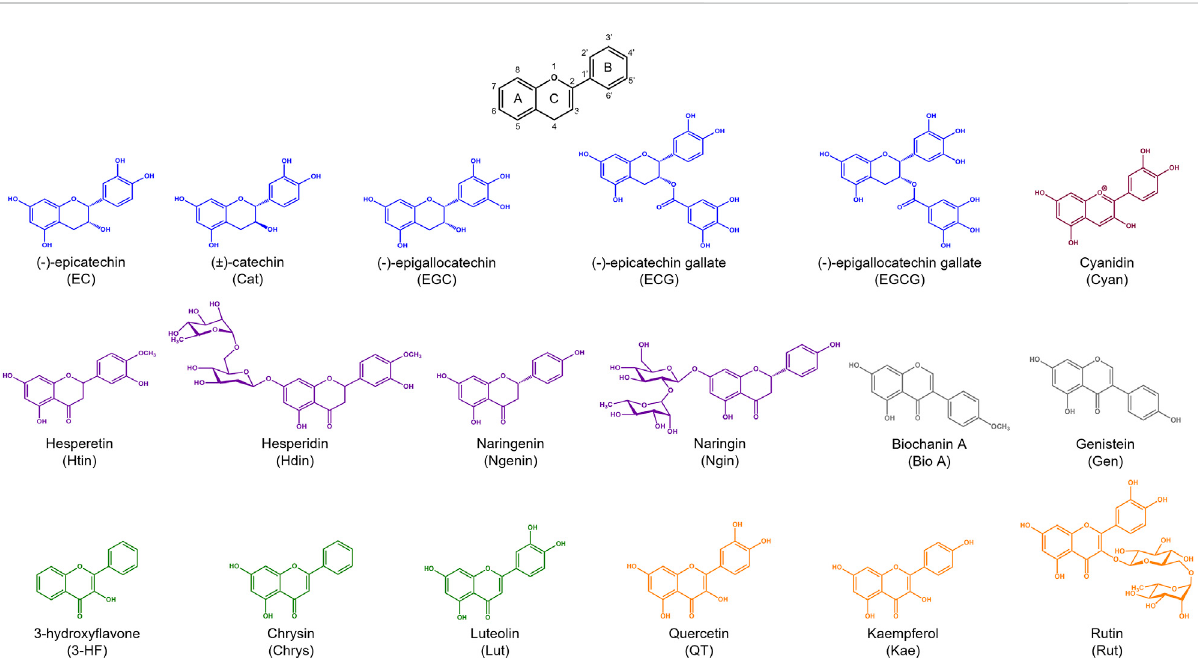
FIGURE 1 The core structure shared by fl avonoids is composed of two benzene rings (rings A and B) connected by a heterocyclic pyran ring (ring C). Flavonoidsubclassesinclude fl avonols(blue), fl avanones(purple), fl avones(green), fl avonols(orange),anthocyanins(maroon),andiso fl